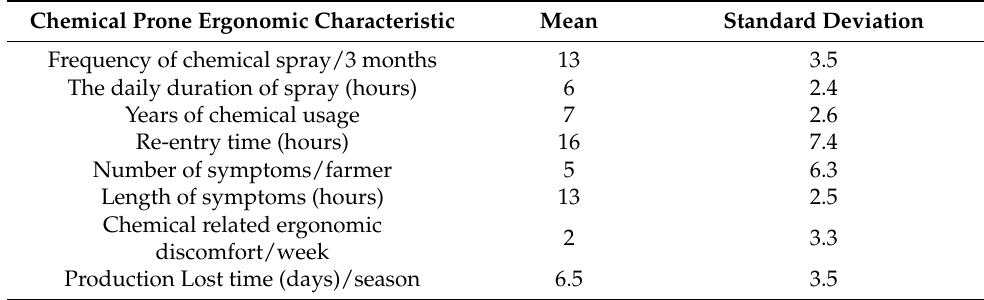
Table 2. Characteristics of farmers related to chemical prone ergonomics (N =